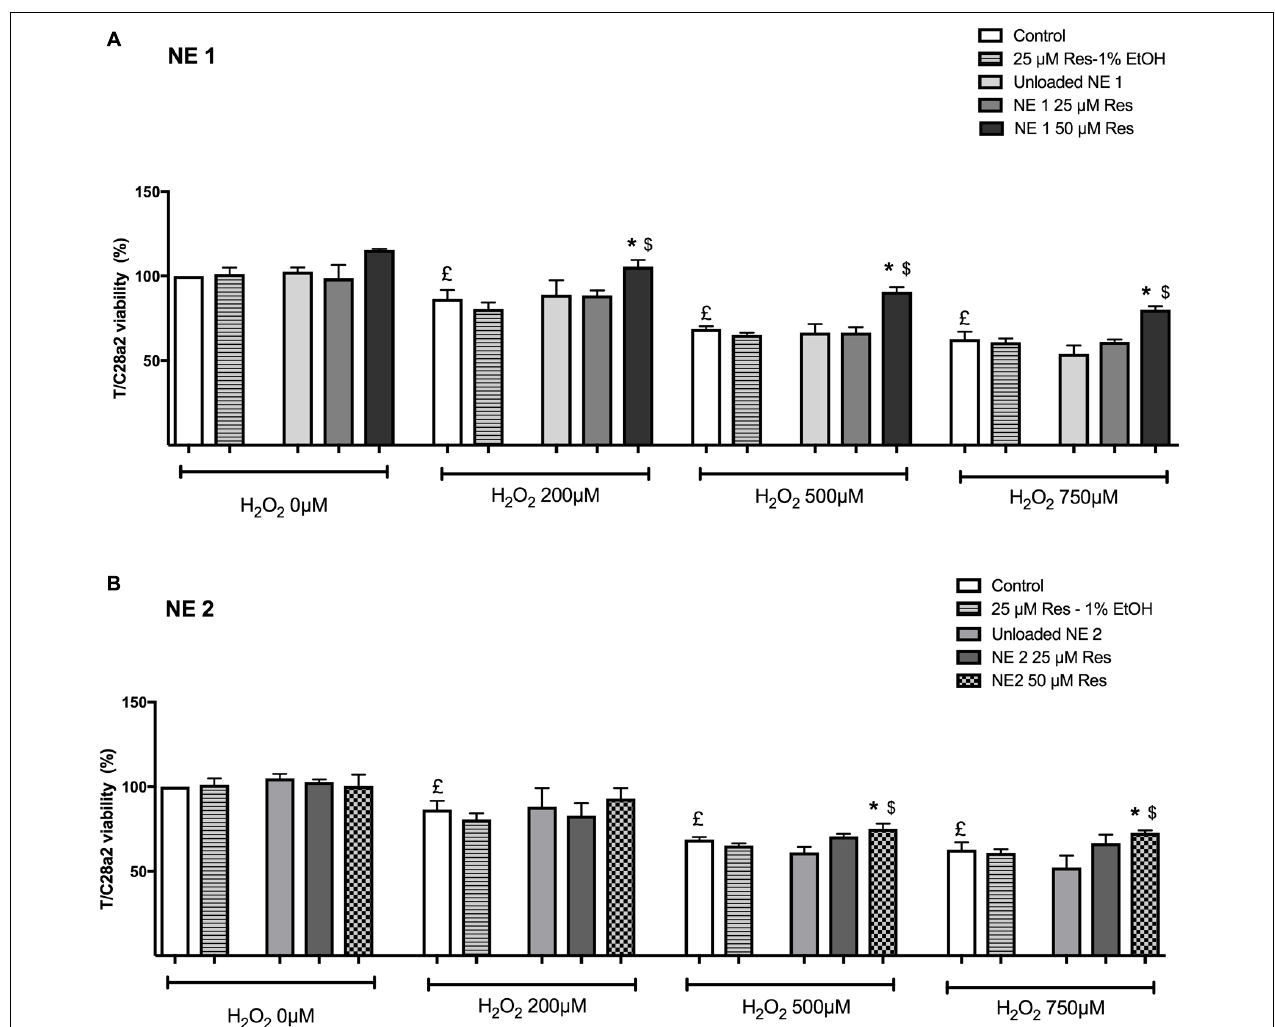
FIGURE 3 | Effect of resveratrol either in the nano-emulsions ( A : NE1; B : NE2) or in the ethanolic solution against oxidative stress-mediated death. Results were expressed as mean viability percentage ± SEM ( n = 4). Control cells were cultured in conventional medium and neither incubated with resveratrol nor H 2 O 2 . Unloaded NE were also evaluated. £ p < 0.05 vs. control cells incubated neither with resveratrol nor H 2 O 2 . ∗ p < 0.05 vs. cells incubated with H 2 O 2 without resveratrol. $ p < 0.05 vs. cells incubated with H 2 O 2 and resveratrol (25 µ M) in ethanolic solution.